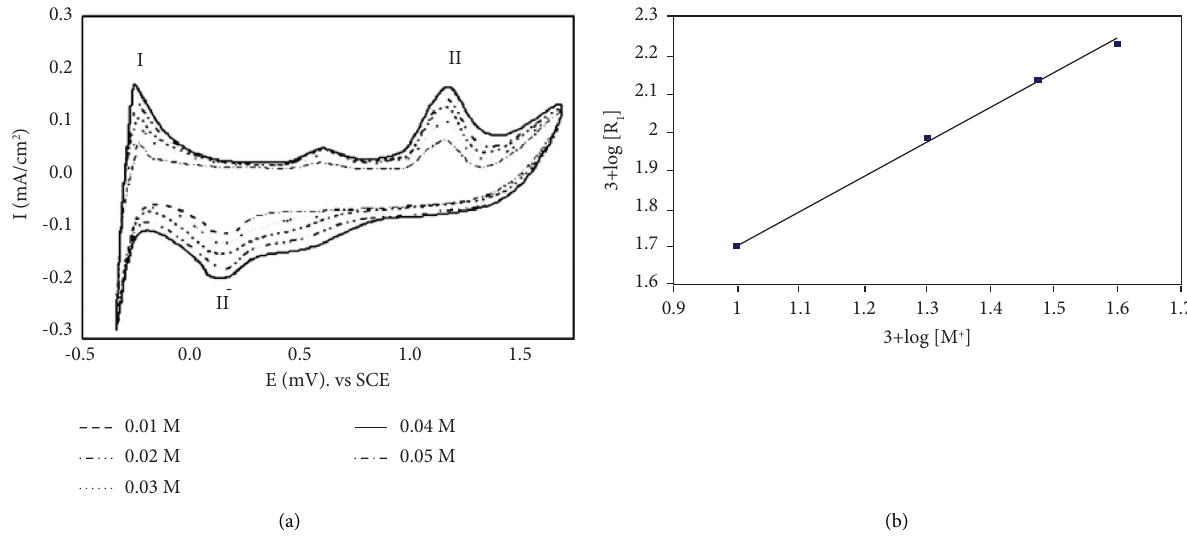
Figure 4: (a) Efect of SA concentration on the cyclic voltammograms for the electropolymerization reaction from a solution containing 0.30mol · L − 1 H 2 SO 4 at 313K with a scan rate 40mVs − 1 . (b) Double logarithmic plot of the initial rate for the electropolymerization reaction versus diferent SA concentrations.